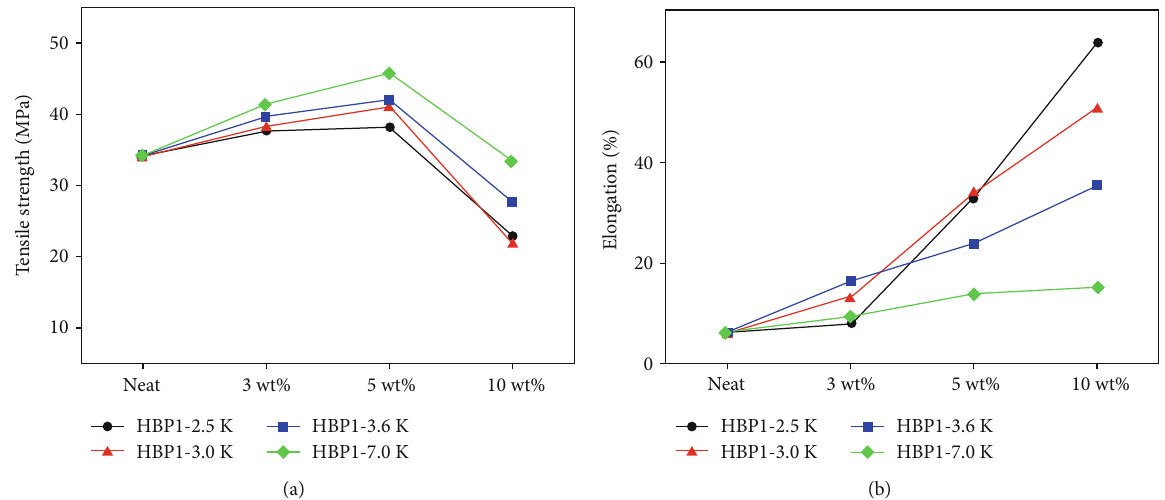
Figure 4: (a) Tensile strength and (b) elongation of epoxy/HBP1 blends with di ff erent molecular weights and HBP loadings.